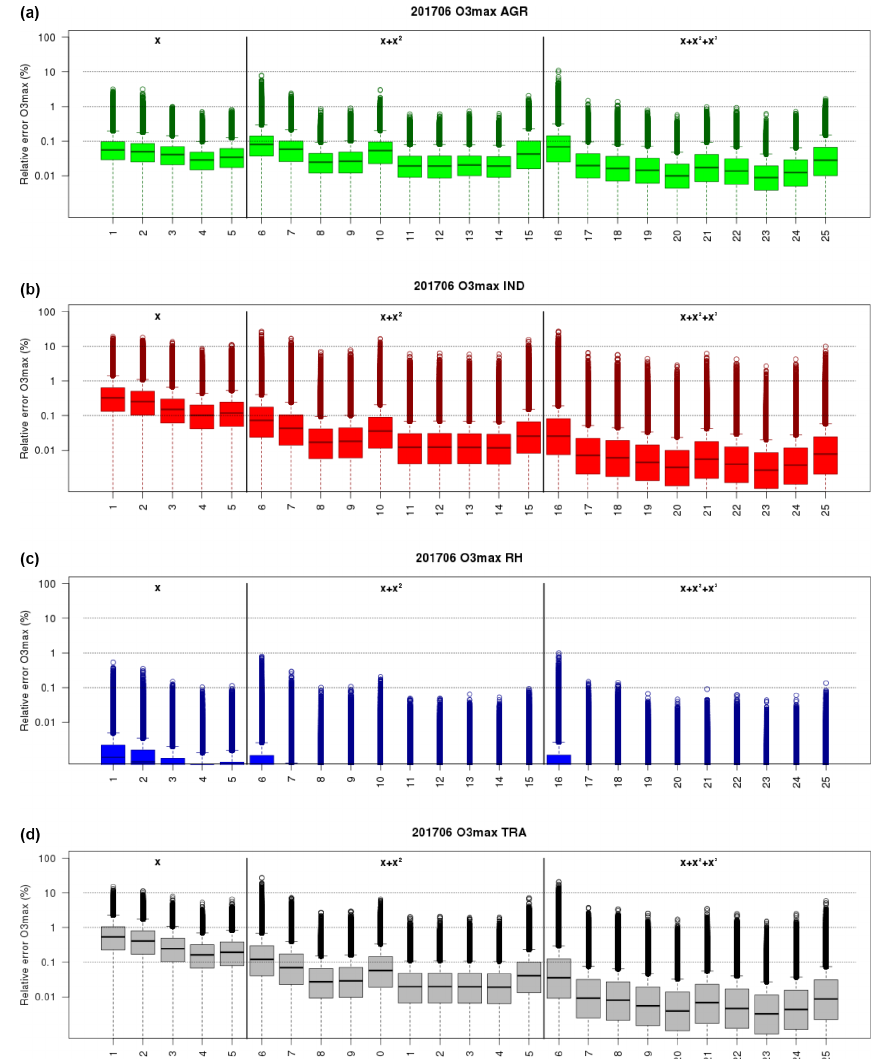
Figure 6. Same as Fig. 5 for O 3